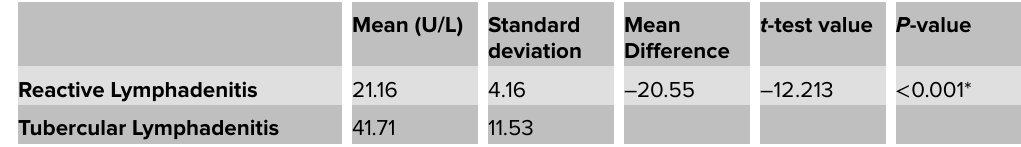
TABLE 1: Comparison of mean serum ADA levels in reactive lymphadenitis (control) and